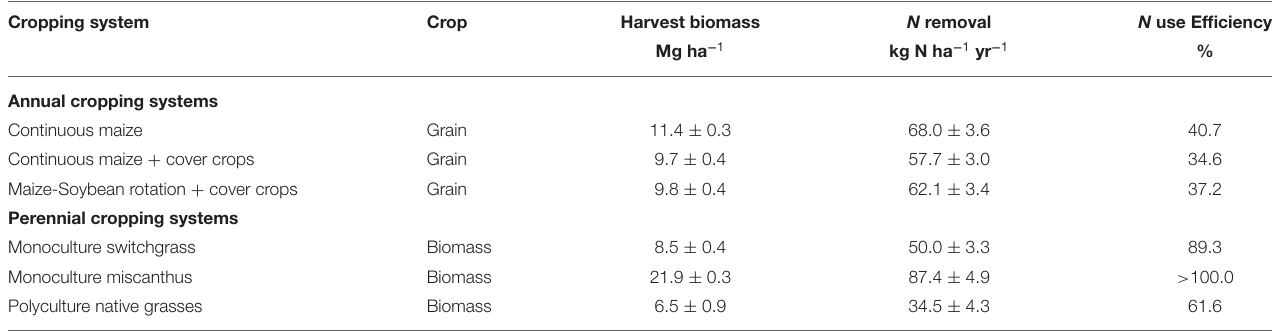
TABLE 2 | Crop yields, nitrogen removal, and nitrogen use efficiency (proportion of fertilizer removed at harvest) in alternative annual and perennial cropping systems at the Bioenergy Cropping Systems Experiment at the W. K. Kellogg Biological Station, Hickory Corners, Michigan in 2014. Cropping